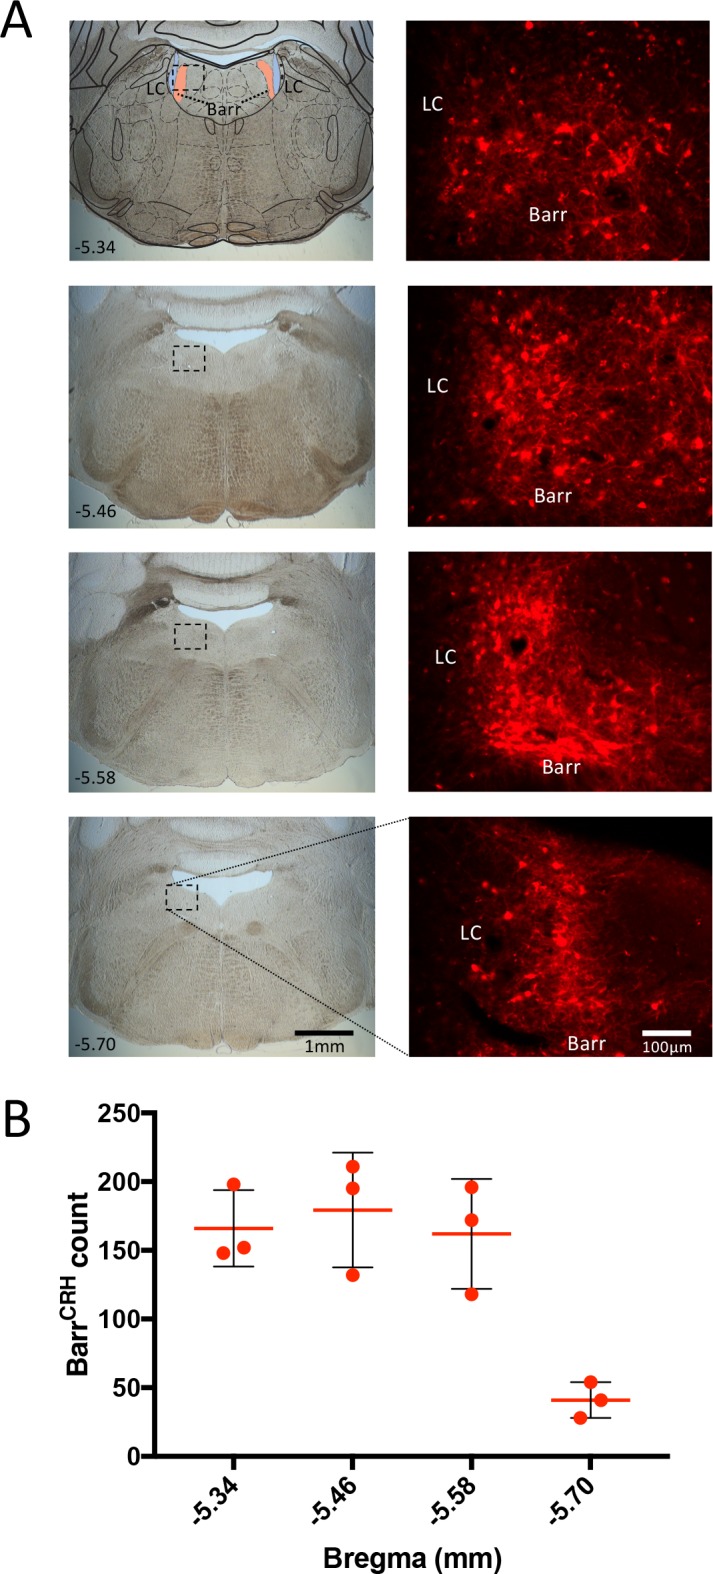
Histological verification of vector expression in Barrington’s nucleus.(A) Following injection of AAV-EF1α-DIO-ChR2-mcherry to CRHCre mice, expression of mCherry was seen in the dorsal pons (Bregma −5.34 to −5.7) in Barrington’s nucleus (overlaid atlas section from Paxinos and Franklin, 2008). (B) Cell counts of transduced neurons in Barrington’s nucleus from three mice showing mean ± SD. Immuno- for mCherry with Alexa594 conjugated secondary antibody. LC – locus coeruleus, Barr – Barrington’s nucleus.